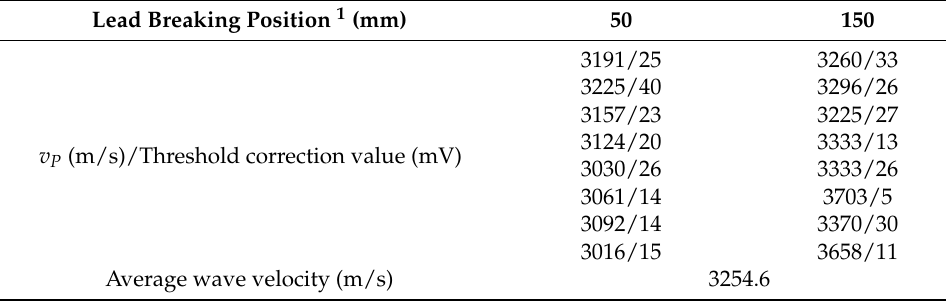
Table 1. Measurement results of the wave velocity by the PLB